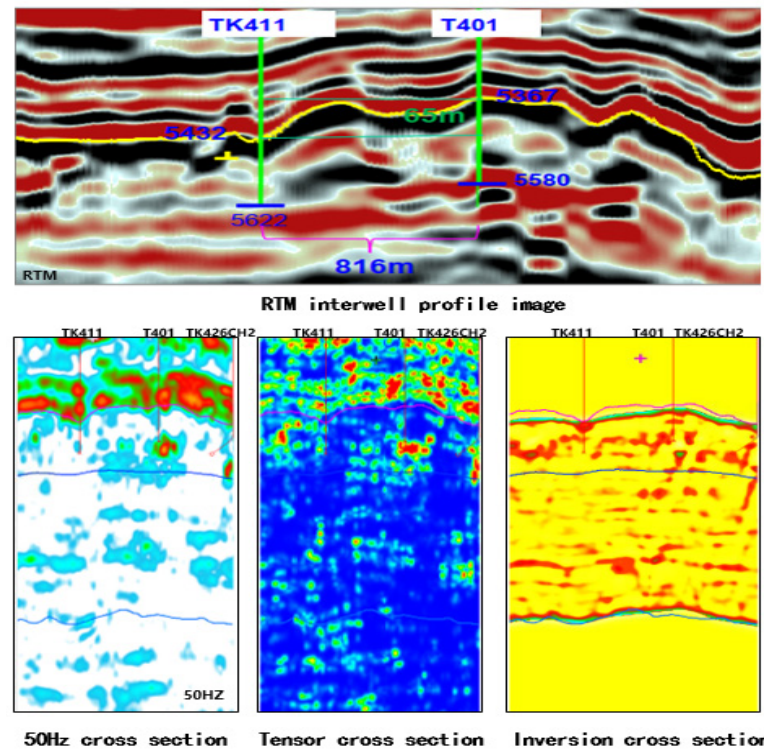
Figure 1. Seismic profile of TK411 well group.